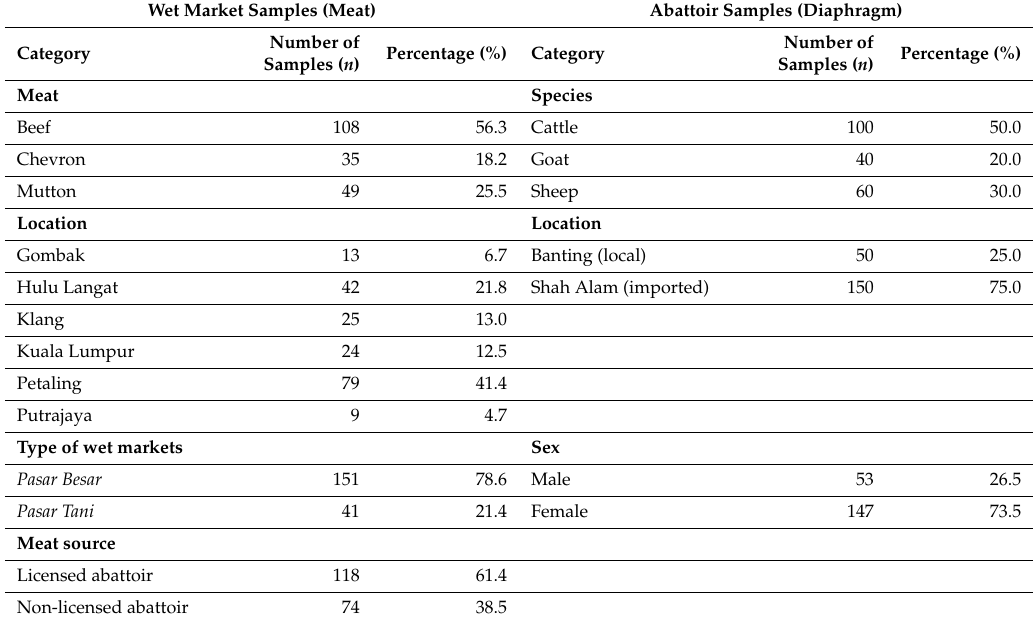
Table 2. Description of meat samples purchased from wet markets in Klang Valley, and abattoirs in